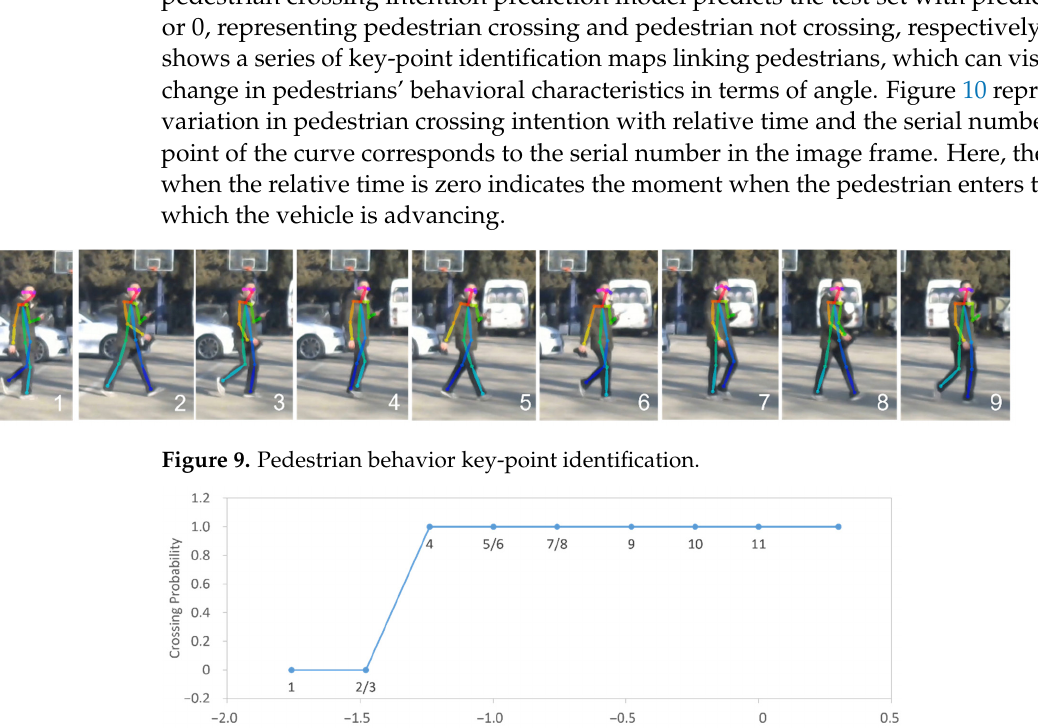
Figure 8. ROC curve.